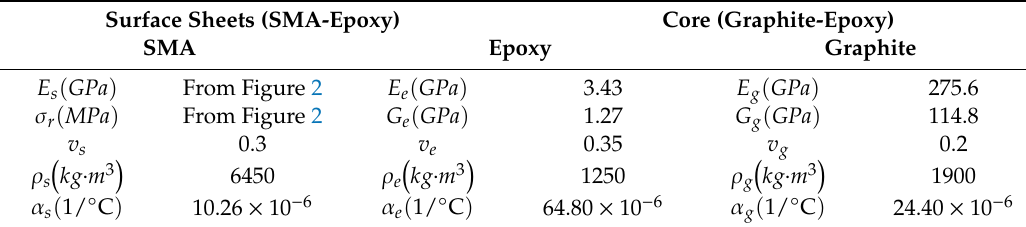
Table 3. Material properties of surface sheets and core.